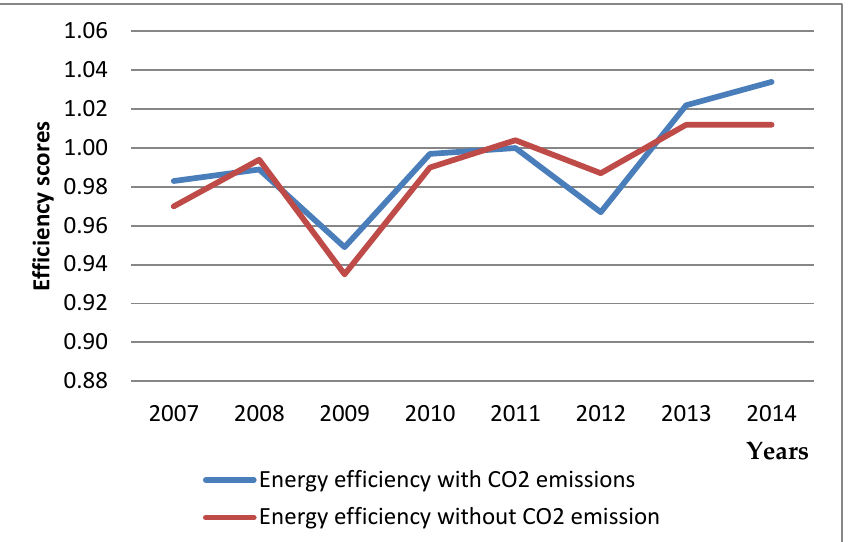
Figure 8. The energy efficiency change estimates in Africa from 2006–2014.